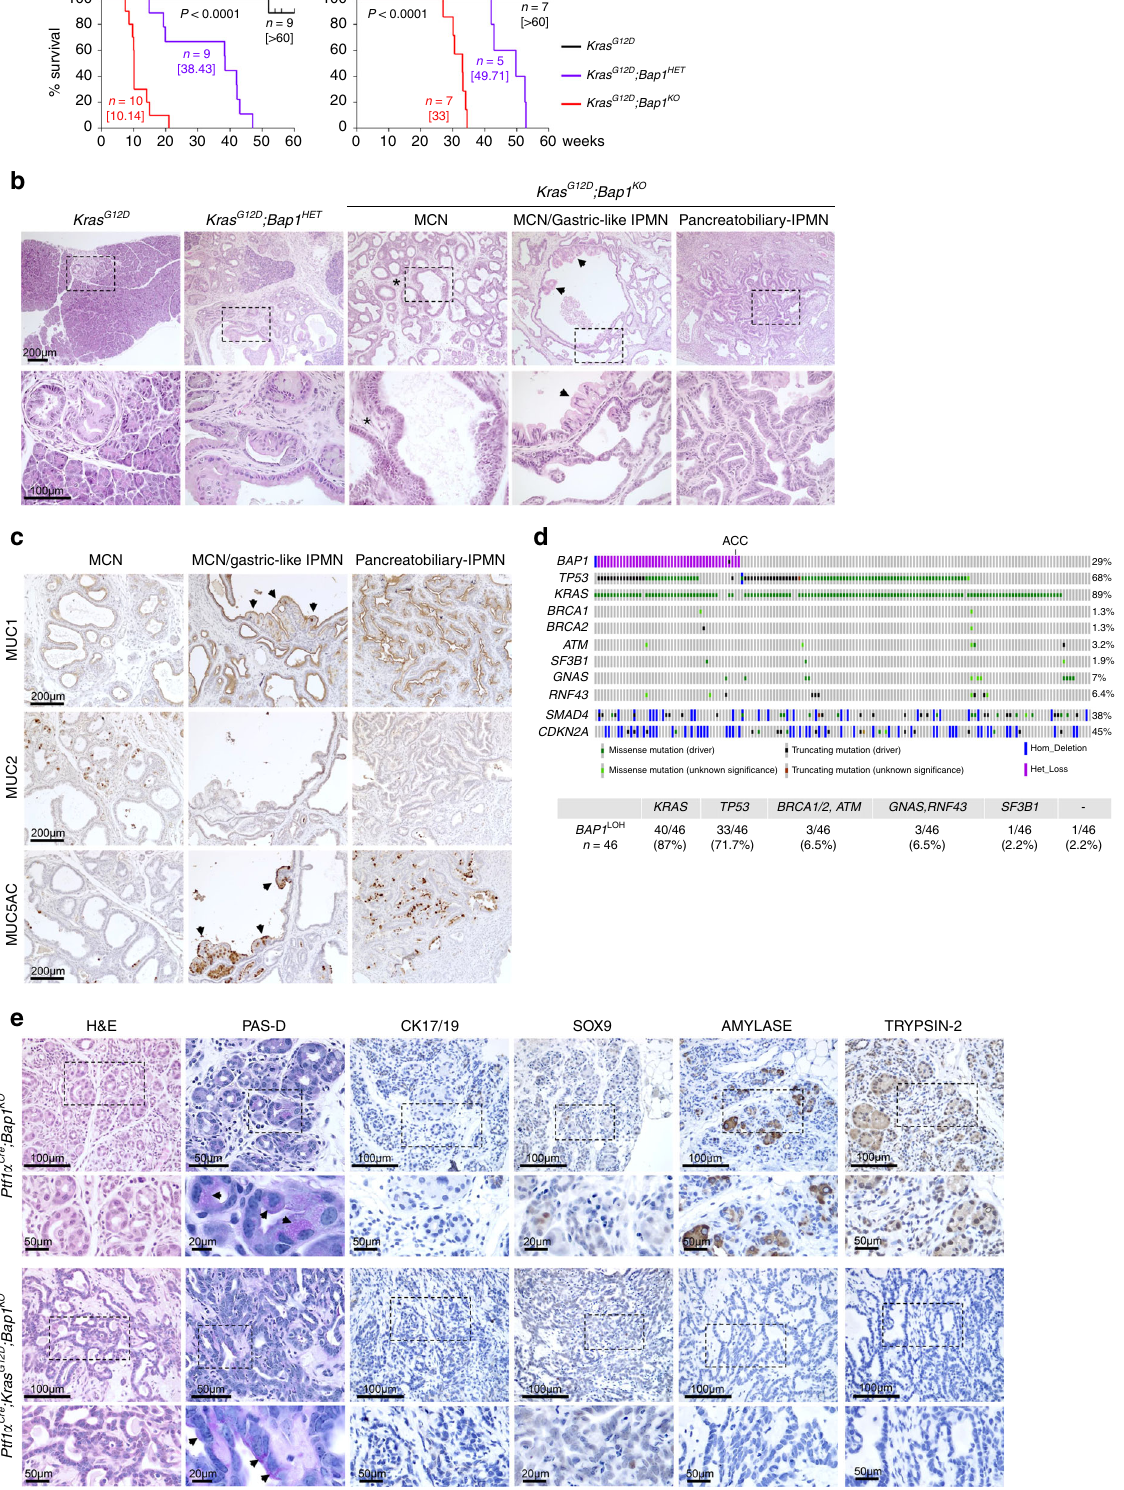
positive, Diastase-resistant (PAS-D) cytoplasmic zymogen gran- ules, a feature of ACC 38 . Consistently, these lesions lacked mucin, Cytokeratin 17/19, and Sox9 expression, but were positive for the acinar markers, Amylase and Trypsin-2 (Fig. 4e, top panel). Likewise, in Ptf1 α Cre ;Bap1 KO ;Kras G12D mice we observed small areas emulating ACC adjacent to PDA with glandular histology